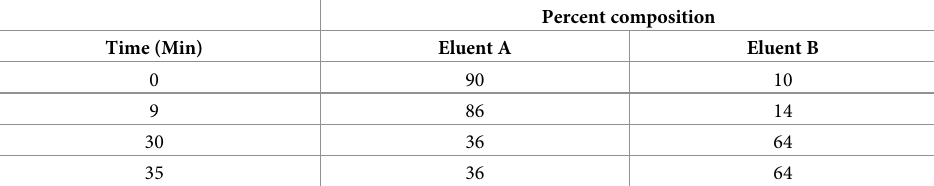
Table 1. Segmented gradient